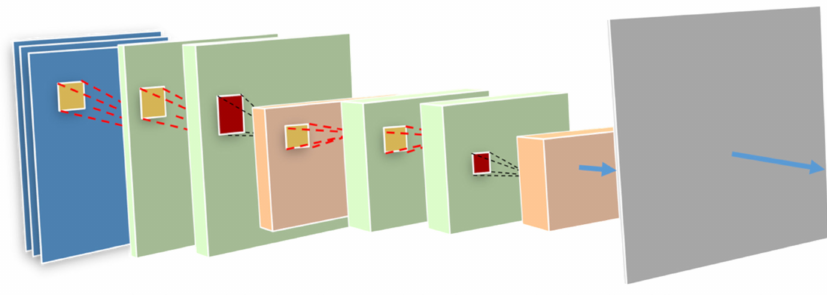
Figure 2. An example of the structure of the convolutional neural network